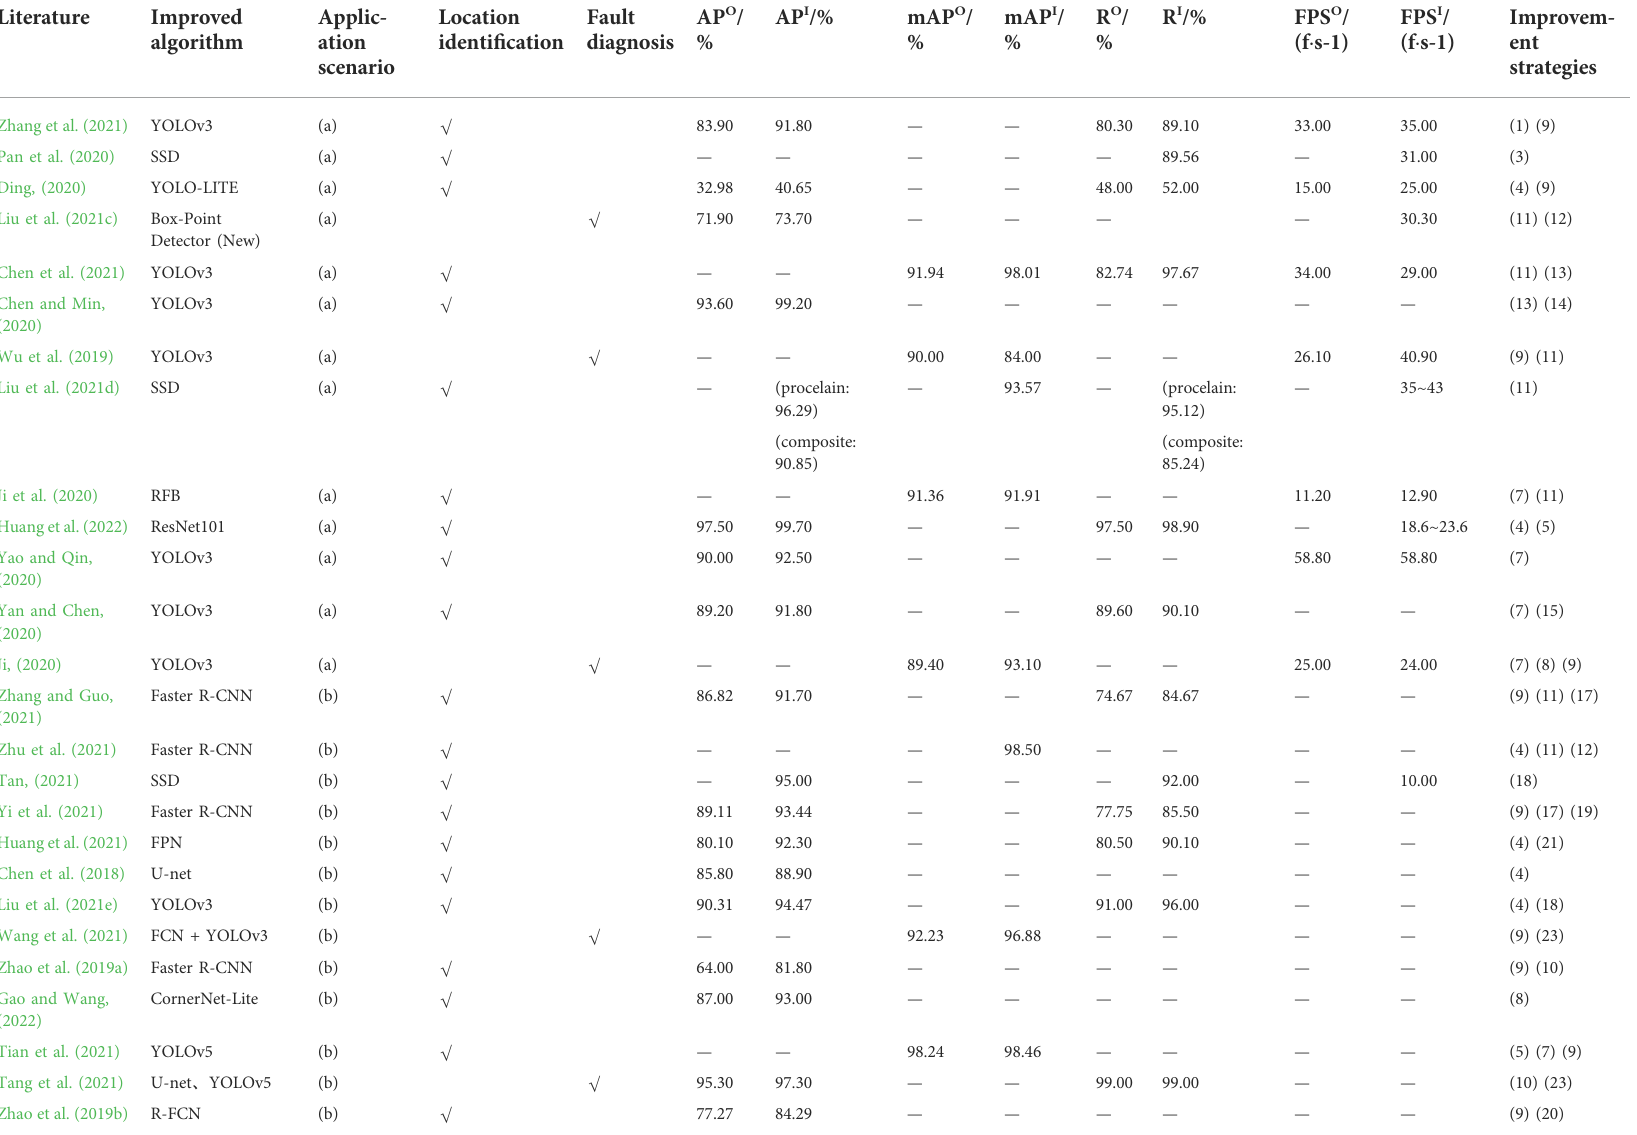
TABLE 3 Evaluation index of detection performance of comprehensive